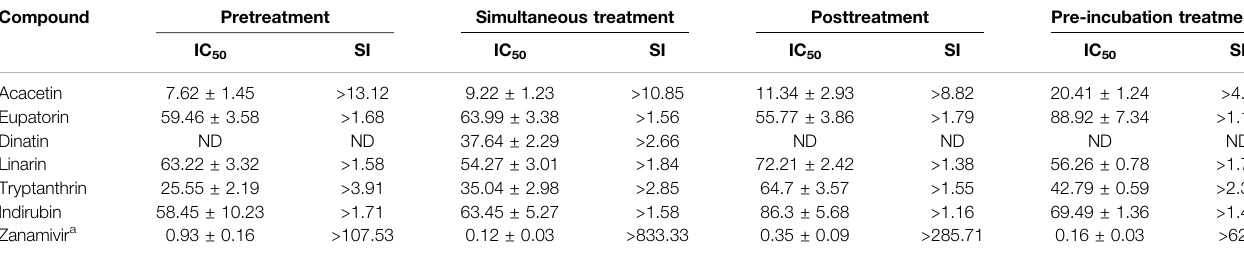
TABLE 2 | Cytopathic effect (CPE) reduction assay results of the six predicted compounds toward the wild-type strain A/PR/8/34 (H1N1) Compound Pretreatment Simultaneous treatment Posttreatment